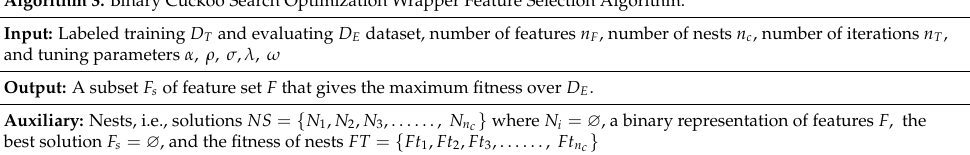
Algorithm 3. Binary Cuckoo Search Optimization Wrapper Feature Selection